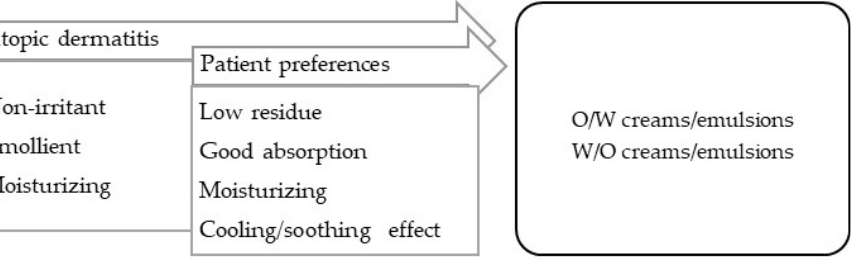
Figure 7. TPP for formulations for treatment of atopic dermatitis and most suitable vehicles/bases.